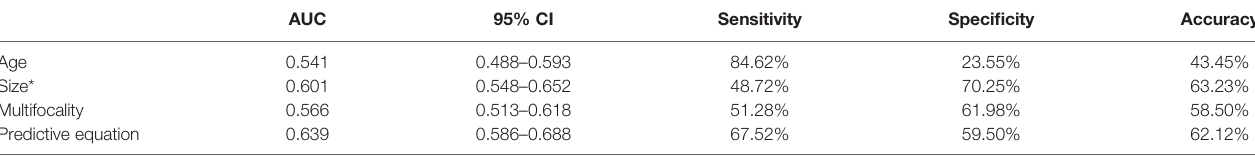
TABLE 4 | ROC analysis for predicting microscopic pN1 in